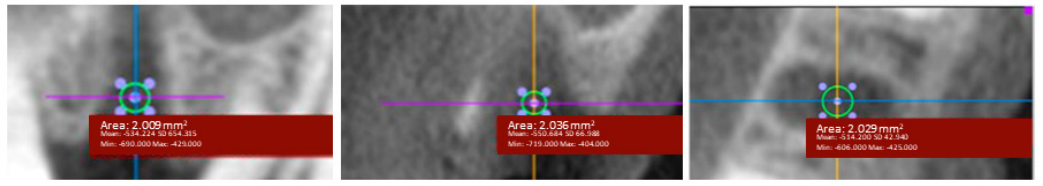
Figure 3. Determination of the region of interest (ROI) with an area of 2 mm2 in three different planes (axial, sagittal, and coronal). Circular areas of 2 mm2 designated as ROIs were